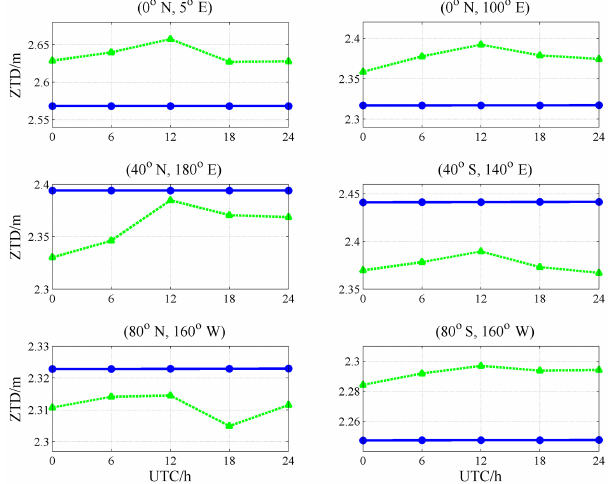
Figure 2. Mean diurnal ZTD values of GGOS grid points with error bars denoting the standard deviations from the average over the year